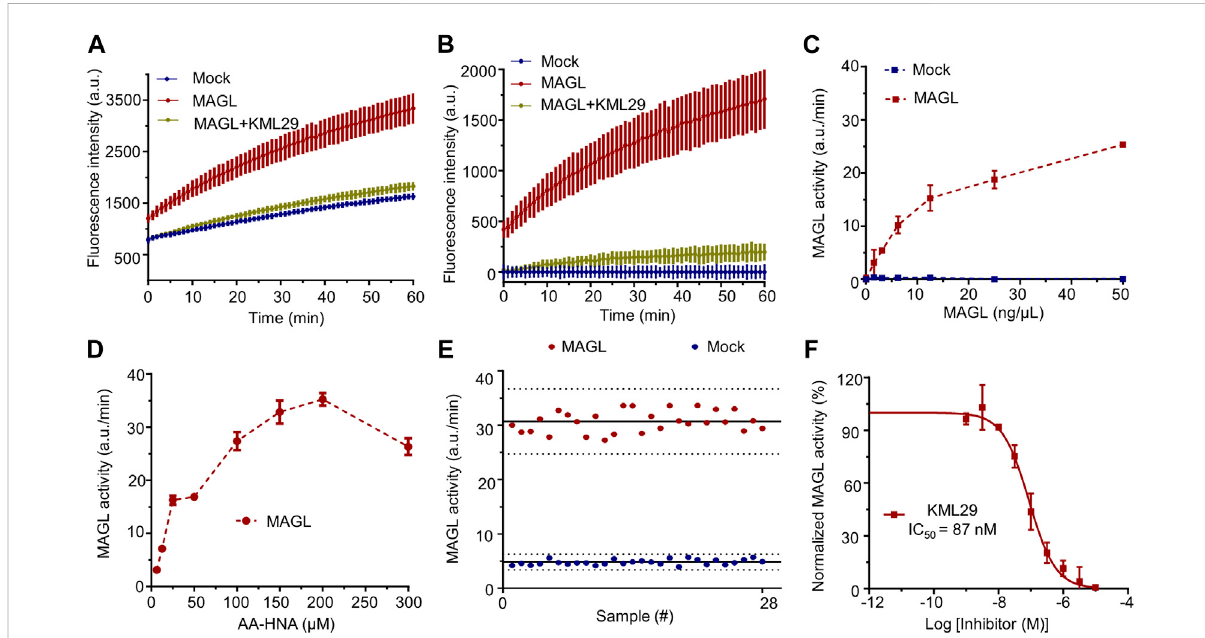
FIGURE 2 Setup and optimization of AA-HNA -based activity assay for MAGL. (A) Time course of AA-HNA hydrolysis by MAGL (50 ng/ μ l), resulting in an increase of fl uorescence over time. Preincubation with MAGL inhibitor KML29 (1 µM) resulted in the reduction of the fl uorescent signal. Membrane proteins from Mock-transfected cells served as a negative control. (B) Time course of 2-AG hydrolysis by MAGL, corrected for background fl uorescence of the Mock-transfected negative control. (C) Optimization of protein concentration for the MAGL activity assay. MAGL activity wasmonitoredintimewithvariousconcentrationsofMAGL.Notably,MAGLactivitywasdeterminedfromtheslopeinthelinearregion(5 – 15 min)of the speci fi c MAGL activity. (D) Optimization of AA-HNA concentration for the MAGL activity assay. (E) Z ′ -factor data plot of AA-HNA -based MAGL activityassay.The solidlinesrepresent themeanslope ofindividual datapoints anddashedlines representtheSDvaluesabove andbelow themean. The measurement was performed in n = 28. Note that MAGL was used as positive control (mean ± SD = 30.66 ± 1.97) and Mock-membranes were used as negative controls (mean ± SD = 4.80 ± 0.50). Z ′ -factor and signal to background (S/B) ratio were determined as 0.71 and 6.39, respectively. (F) Dose-response curve and IC 50 determination of MAGL inhibitor KML29. Proteins were incubated with DMSO (vehicle) or various concentrations of the inhibitor for 30 min at room temperature. Data were corrected for background fl uorescence observed for Mock-transfected membranes treated with DMSO. The corrected positive control of MAGL activity was normalized as 100%, and the obtained percentage values of MAGL